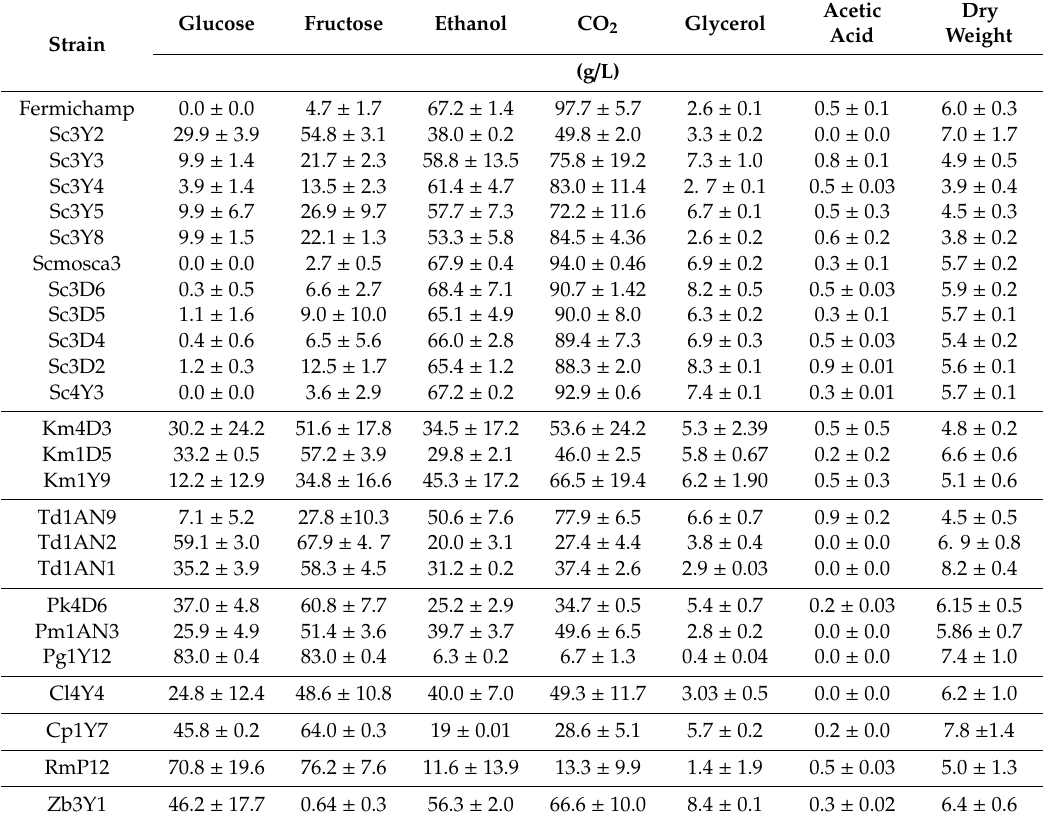
Table 2. Primary metabolite profiles and hexose consumption for all the yeasts tested at 96 h of fermentation in synthetic medium M3, 200 g / L of initial